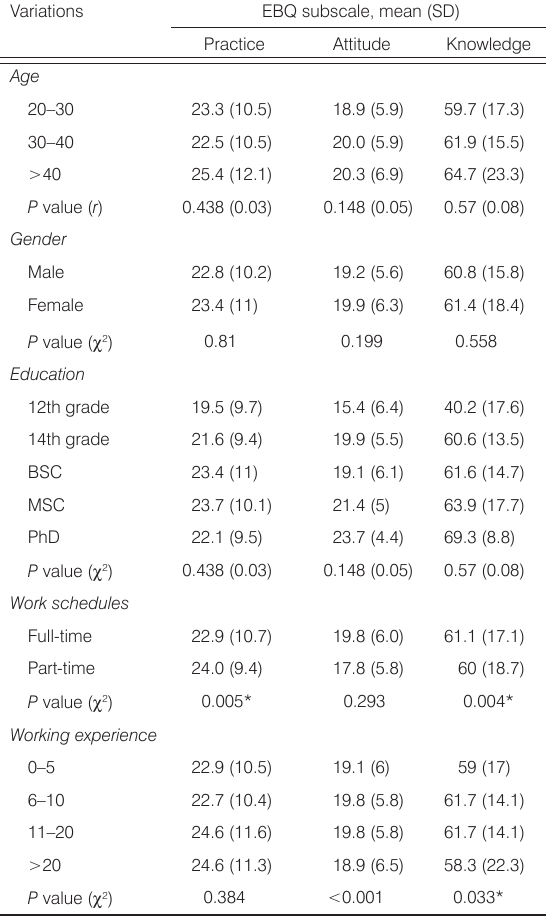
Table 4. Descriptive statistics for different EBP use, attitude, and knowledge/skill by age, gender, education level, work schedule, and working